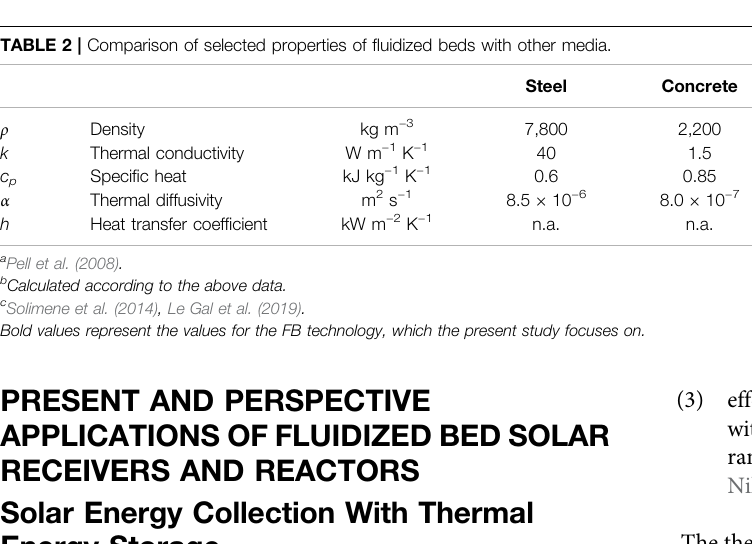
TABLE 2 | Comparison of selected properties of fl uidized beds with other